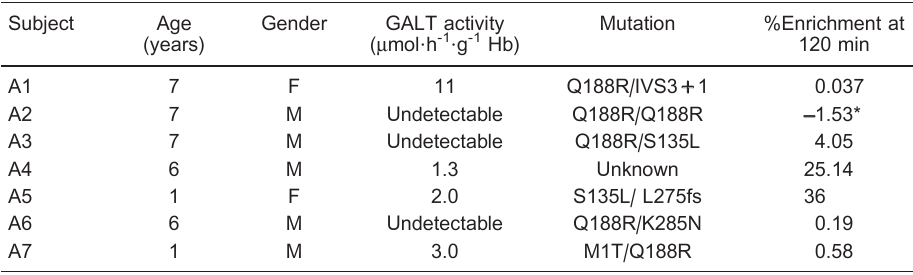
Table 1. Gene characteristics, enzyme activity and %CO 2 enrichment with 13 C at 120 min in children with galactosemia